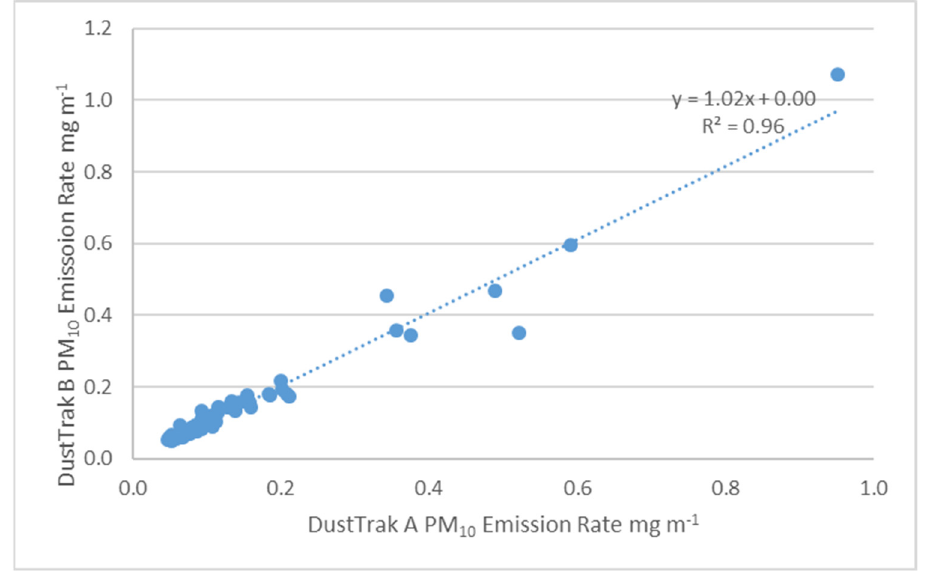
Figure 3. Scatter plot of PM 10 emission rates determined from collocated rear DustTraks.